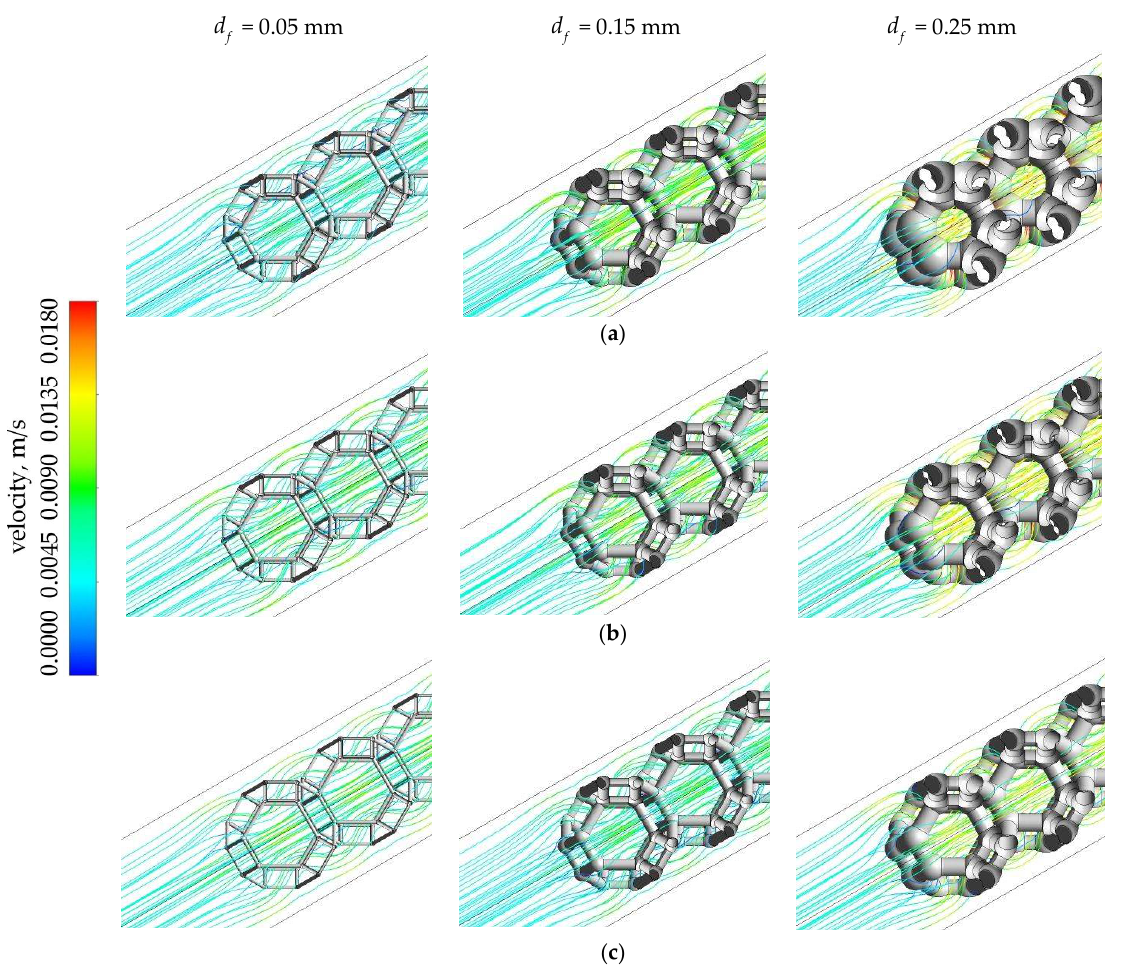
d : ( a ) d and d = 2.0 mm. ( b ) f с с